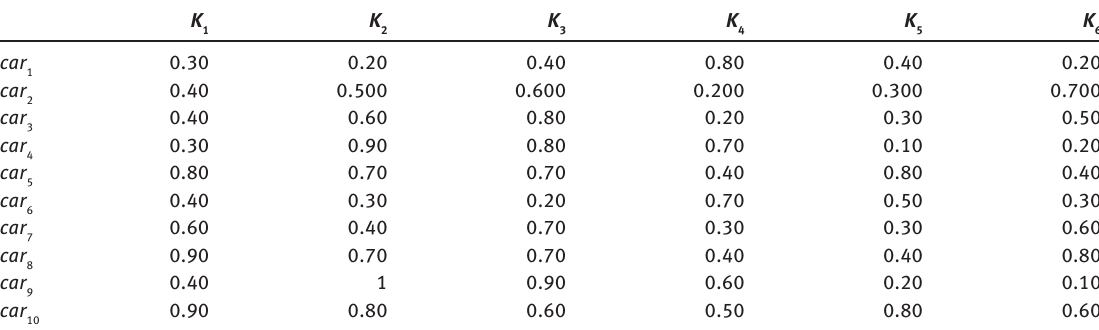
Table 2: Attributes Used to Describe Car Dataset.